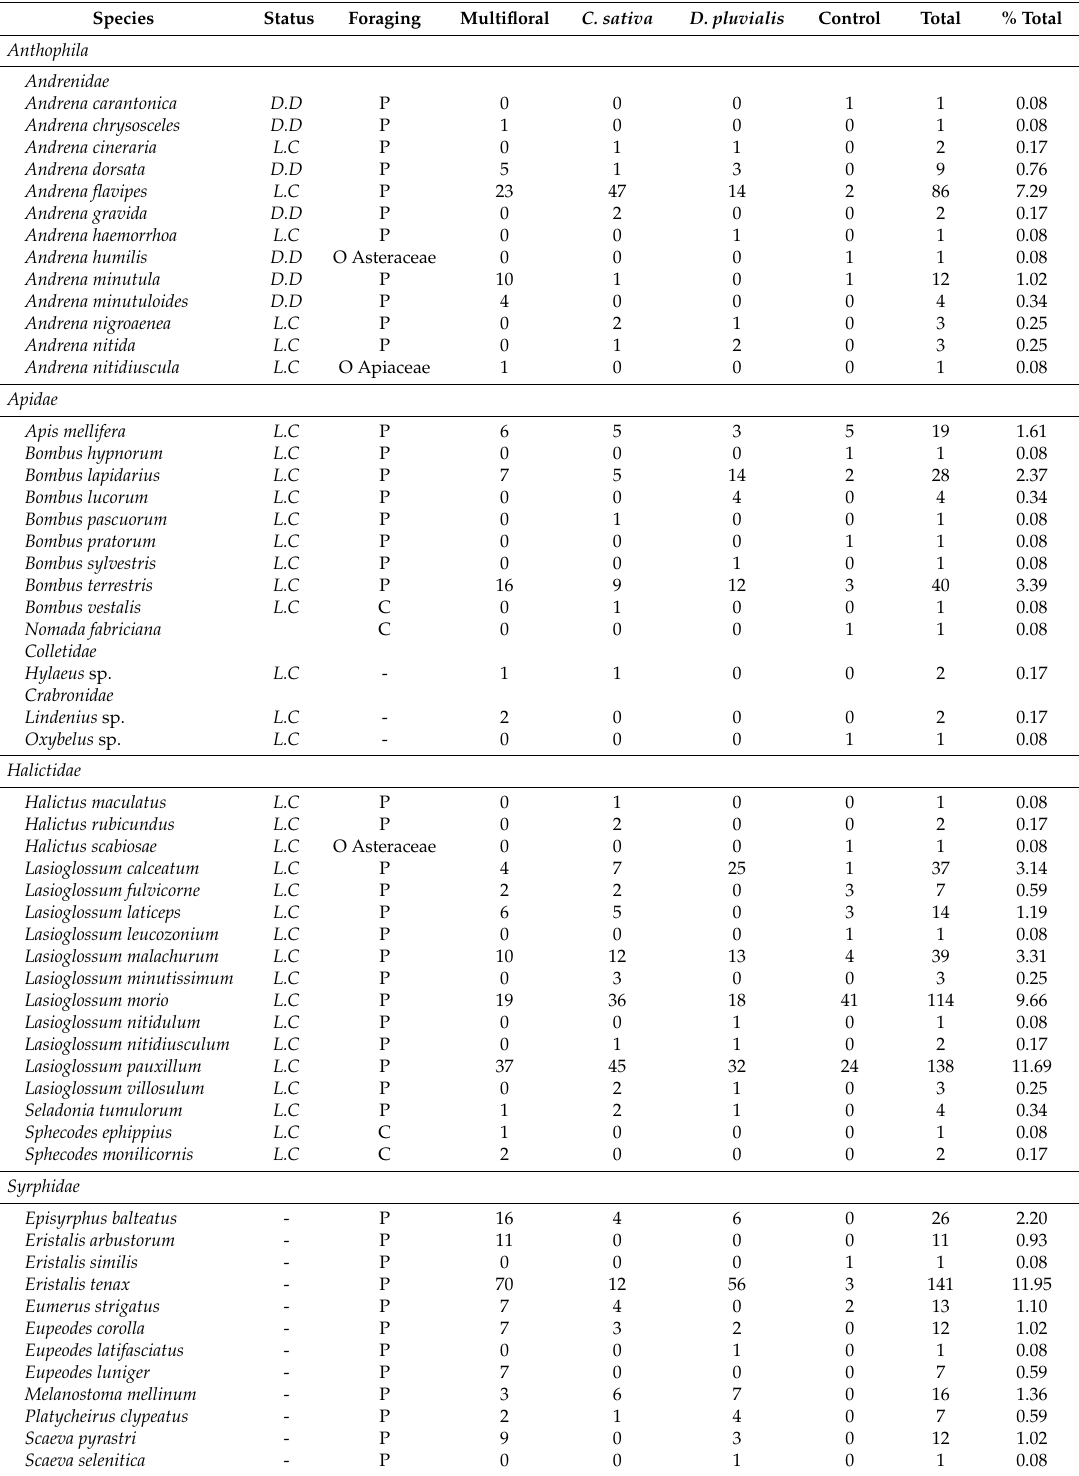
Table 1. Abundance of all bee and hoverfly species collected with pan traps and during transects in each treatment. The endangered status from the European red list of bees [56] for each bee species is indicated (LC: Minor concern; DD: insufficient data). To our knowledge, no endangered status information is available for hoverflies. Foraging traits are also pointed out (P: Polylectic; O: oligolectic with the family of flower; C: cuckoo bees or